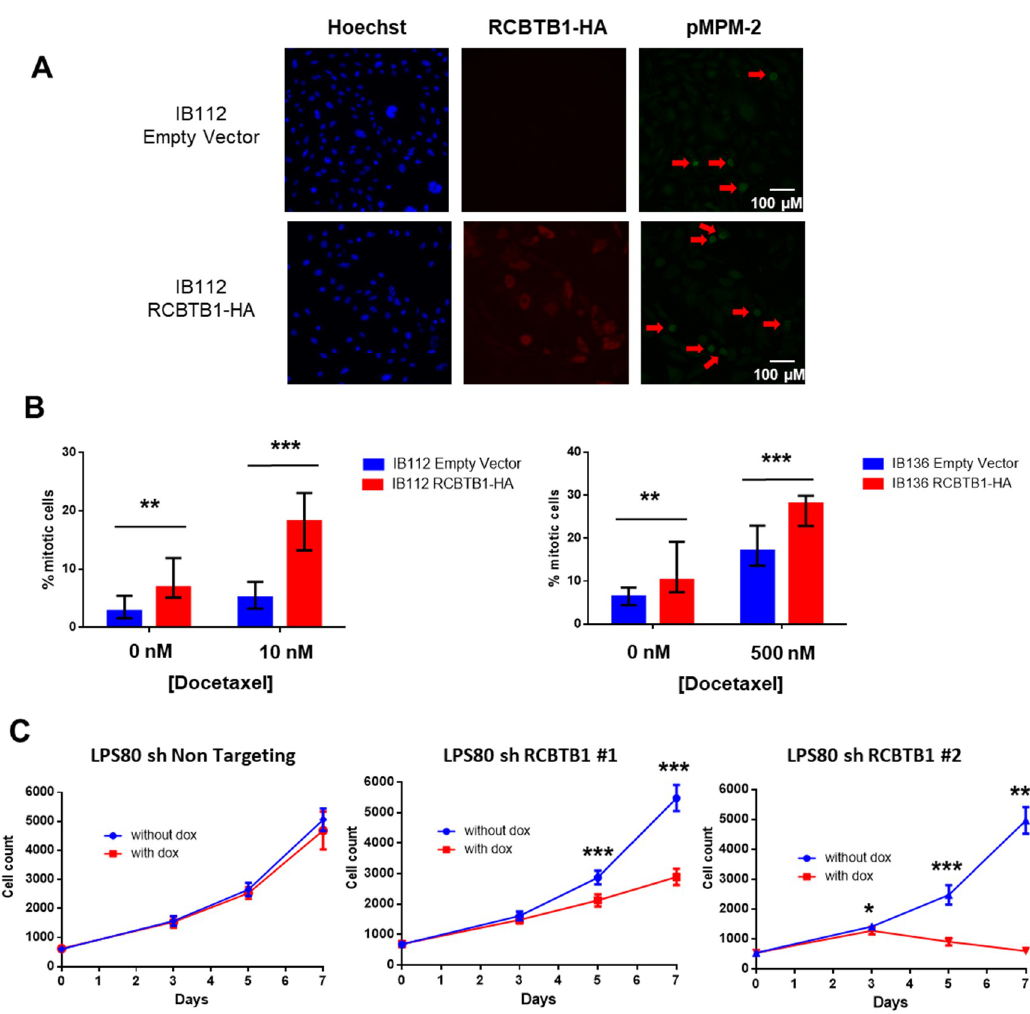
Figure 5. RCBTB1 overexpression increases the percentage of mitotic cells in two leiomyosarcoma (LMS) cell lines, whereas its downregulation reduces cell proliferation in a dedifferentiated liposarcoma cell line. ( A , B ) RCBTB1 was overexpressed by lentiviral transduction in IB112 and IB136. Cells were treated with docetaxel (at 10 nM and 500 nM for IB112 and IB136, respectively) for 24 h and then were fixed for fluorescent staining. Nuclei were stained with Hoechst. Mitosis-specific marker pMPM-2 (green) and RCBTB1-HA (red) dual staining was analyzed by epifluorescence microscopy. ( A ) These images are representative of the results obtained with IB112 LMS cell lines Scale bare: 100 µ M. ( B ) Histograms sum up results that are representative of three independent experiments. Data shown correspond to median (IQR). ( C ) Cell proliferation of the LPS80 cell line expressing the different shRNAs was measured by cell counting using a flow cytometer and compared to respective conditions without doxycycline. Data shown are representative of three independent experiments with eight replicates and represented as mean (SD). * p < 0.05, ** p < 0.01, *** p < 0.001.